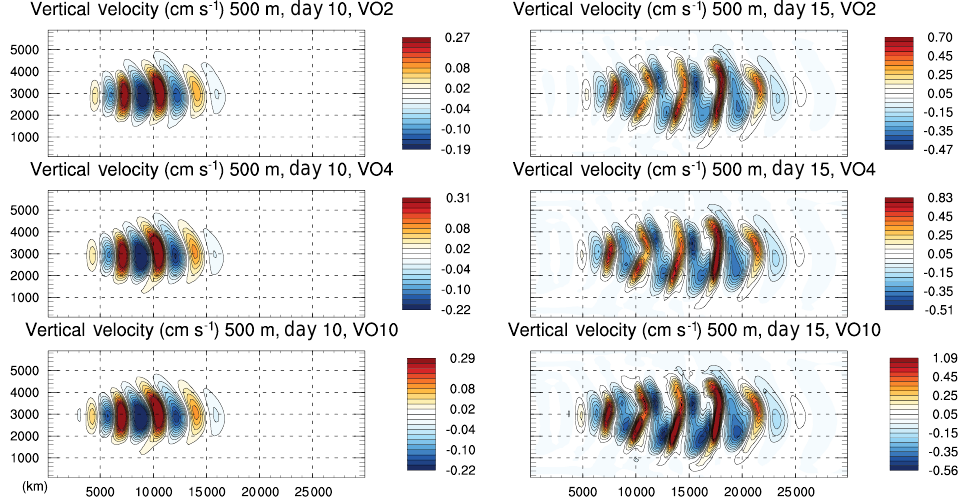
Figure 5. Baroclinic wave in a Cartesian channel at vertical orders 2, 4, and 10. Vertical velocity at 500m on days 10 and 15 at the resolution (cid:49)x = 200km, (cid:49)y = 200km, (cid:49)z = 1 . 5km. Contour interval: 2 . 0 × 10 − 3 ms − 1 .